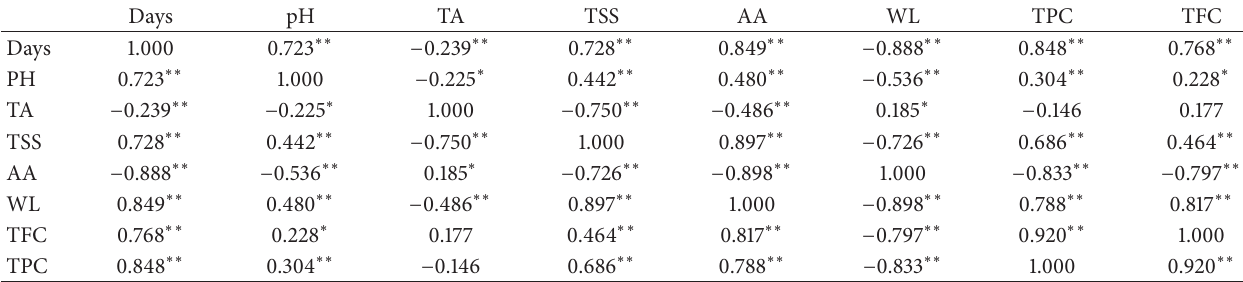
Table 1: Correlation coefficients between physicochemical and microbial quality parameters of orange slices stored at 4 ∘ C on day